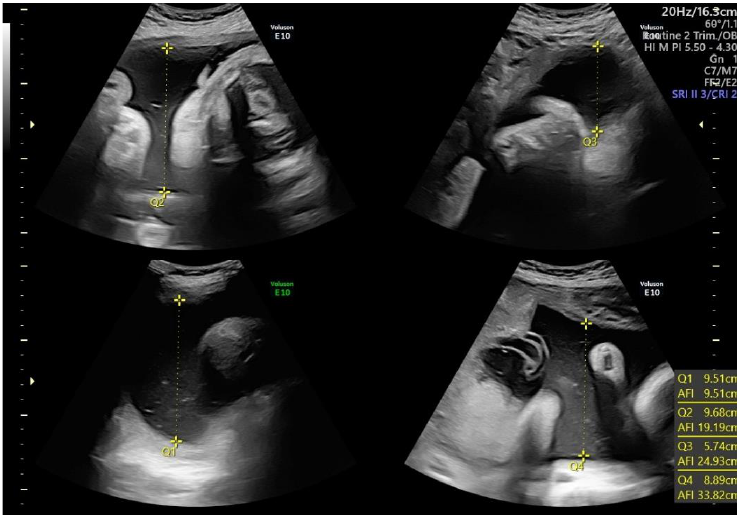
Figure 3. Polyhydramnios. Q: quadrant. AFI: Amniotic Fluid Index. Table 2. Polyhydramnios: classification by severity.